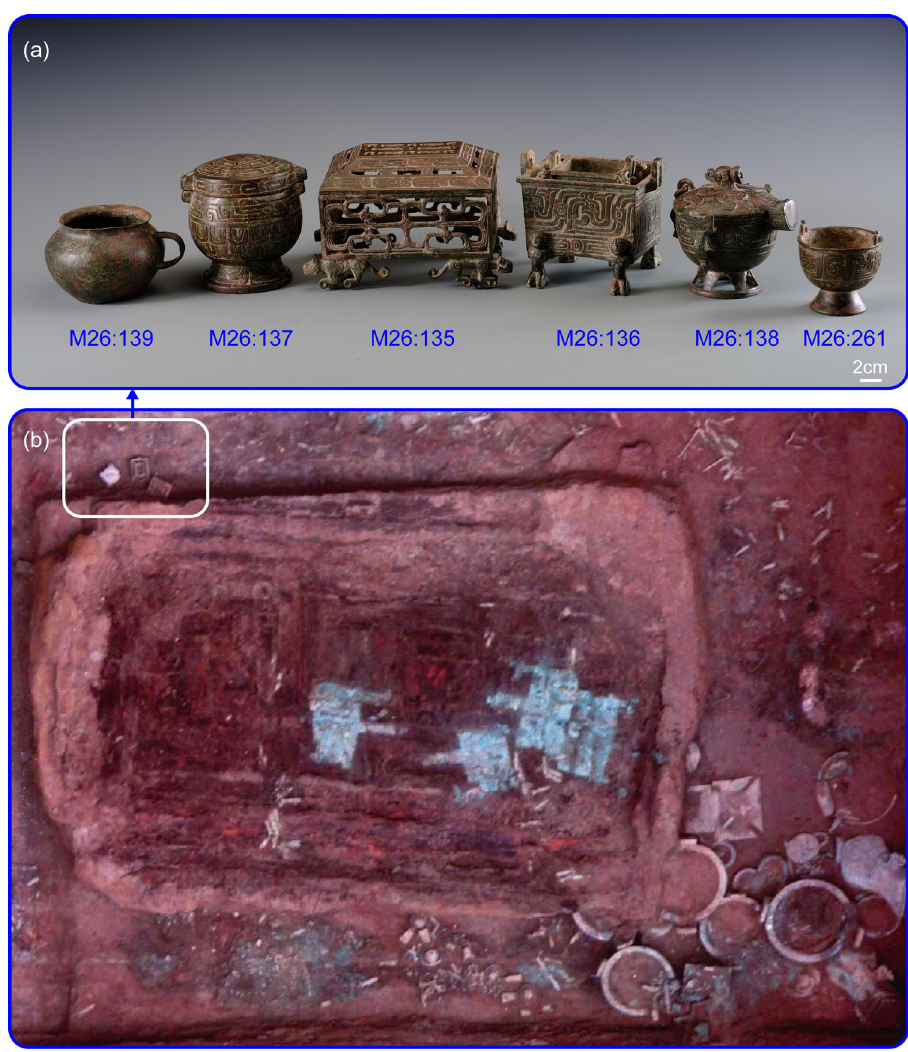
Fig. 3 The layout of tomb M26 (occupier Zhongjiang , a queen of Rui state). a Miniature bronze items M26:138, M26:137, M26:261, M26:139, M26:135, and M26:136 as a set of funerary items; b vertical view of tomb M26. In b , the blue box indicates the location of the items in the outer cof fi n sitting northeast of the head of the occupier in tomb M26. Decorative patterns of these miniature vessels are illustrated in Fig. S1, Supplementary